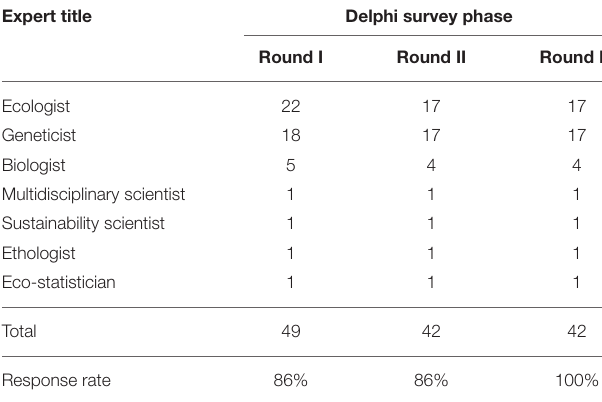
TABLE 2 | Total response rate to this survey, and response rate by expert